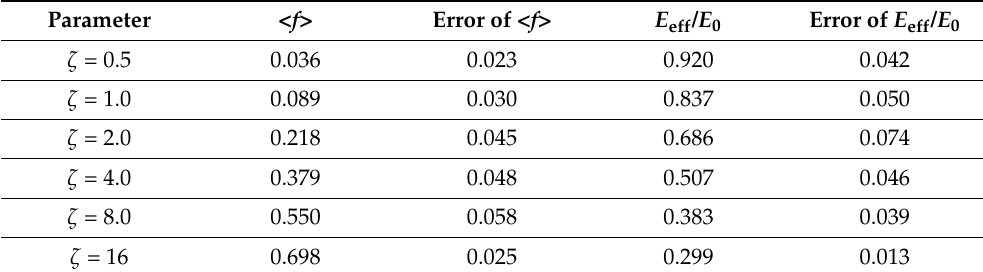
Table 3. Macroscopic porosity <f> and effective elastic modulus E eff / E 0 of multifractal porous materials synthesized by the compound Poisson